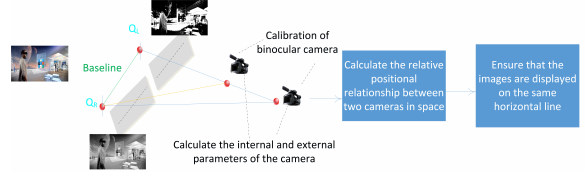
Fig. 1. Principle of binocular stereo imaging way, it is easy to change the face and not keep up with the head movement, which causes the user to feel dizzy and cause image distortion. Eye